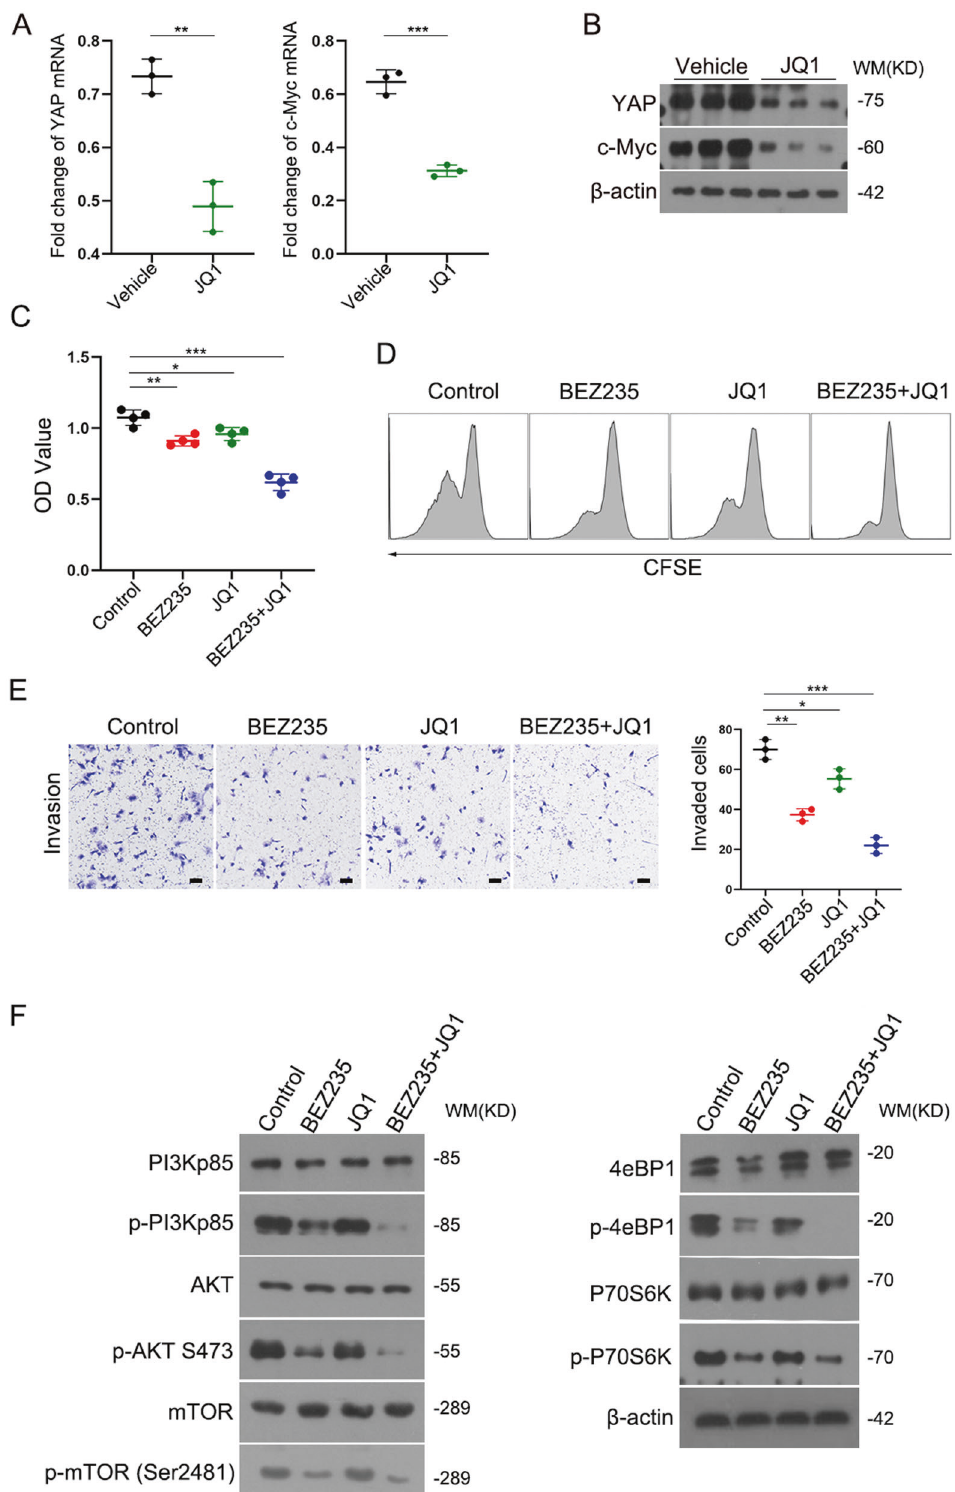
Fig. 5 The combination of BET protein inhibition and PI3K/mTOR dual inhibition ef fi ciently suppressed ICC progression in vitro. A Fold change in YAP and c-Myc mRNA expression level in RBE cells treated with DMSO or JQ1 (500 nM) for 24 hours. B western blot analysis of YAP and c-Myc protein levels in RBE cells treated with DMSO or JQ1 (500 nM) for 24 hours. C CCK-8 assay and D CFSE assay showing the cell proliferation ability in control, BEZ235, JQ1, and combination treatment groups. E Transwell assay showing the invasion potential of the four treatment groups. Magni fi cation, ×100; scale bar, 100 μ m. F RBE cells was incubated with DMSO, BEZ235 (100 nM), JQ1 (500 nM) and combination treatment for 24 hours, respectively. The cell lysates were gathered and the designated proteins (PI3Kp85, p-PI3Kp85, AKT, p-AKT (Ser473), mTOR, p-mTOR (Ser2481), 4eBP1, p-4eBP1, P70S6K and p-P70S6K) were detected by western blot analysis. The data are shown as the mean ± SEM (* p < 0.05, ** p < 0.01, *** p < 0.001). Cell Death and Disease (2021)